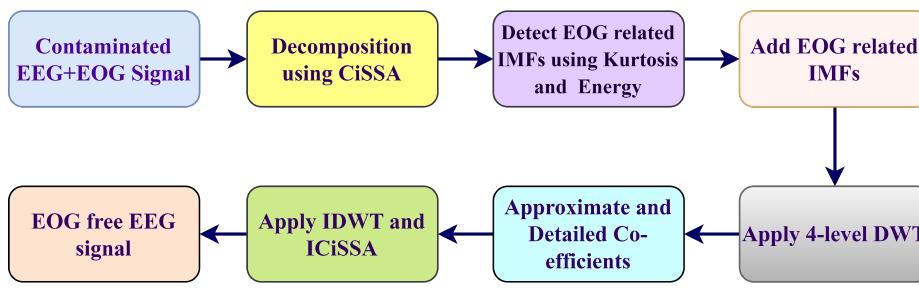
Figure 2. Proposed methodology